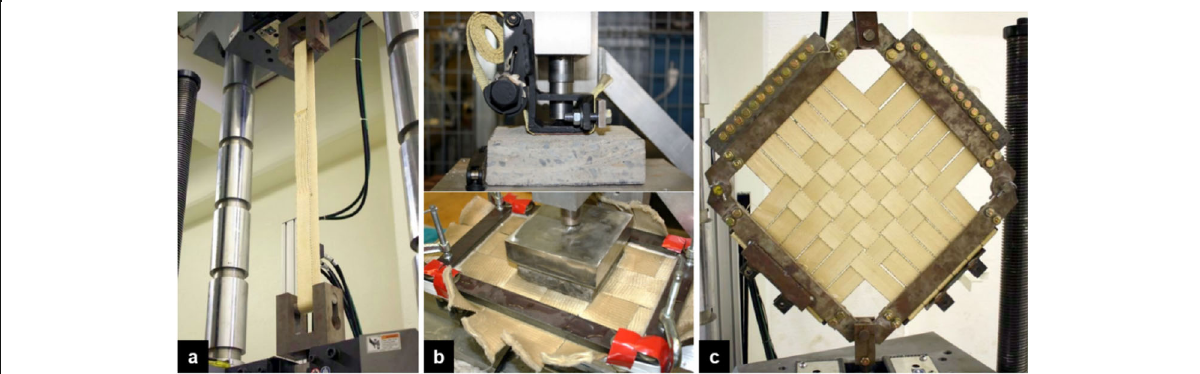
Fig. 5 Phase 2b, material testing: a Tensile test of single loop stitched Vectran webbing; b Friction testing of single Vectran webbing on concrete (top) and friction testing of woven webbings on concrete (bottom) [26]; c Picture frame shear testing of Vectran woven webbing [89,